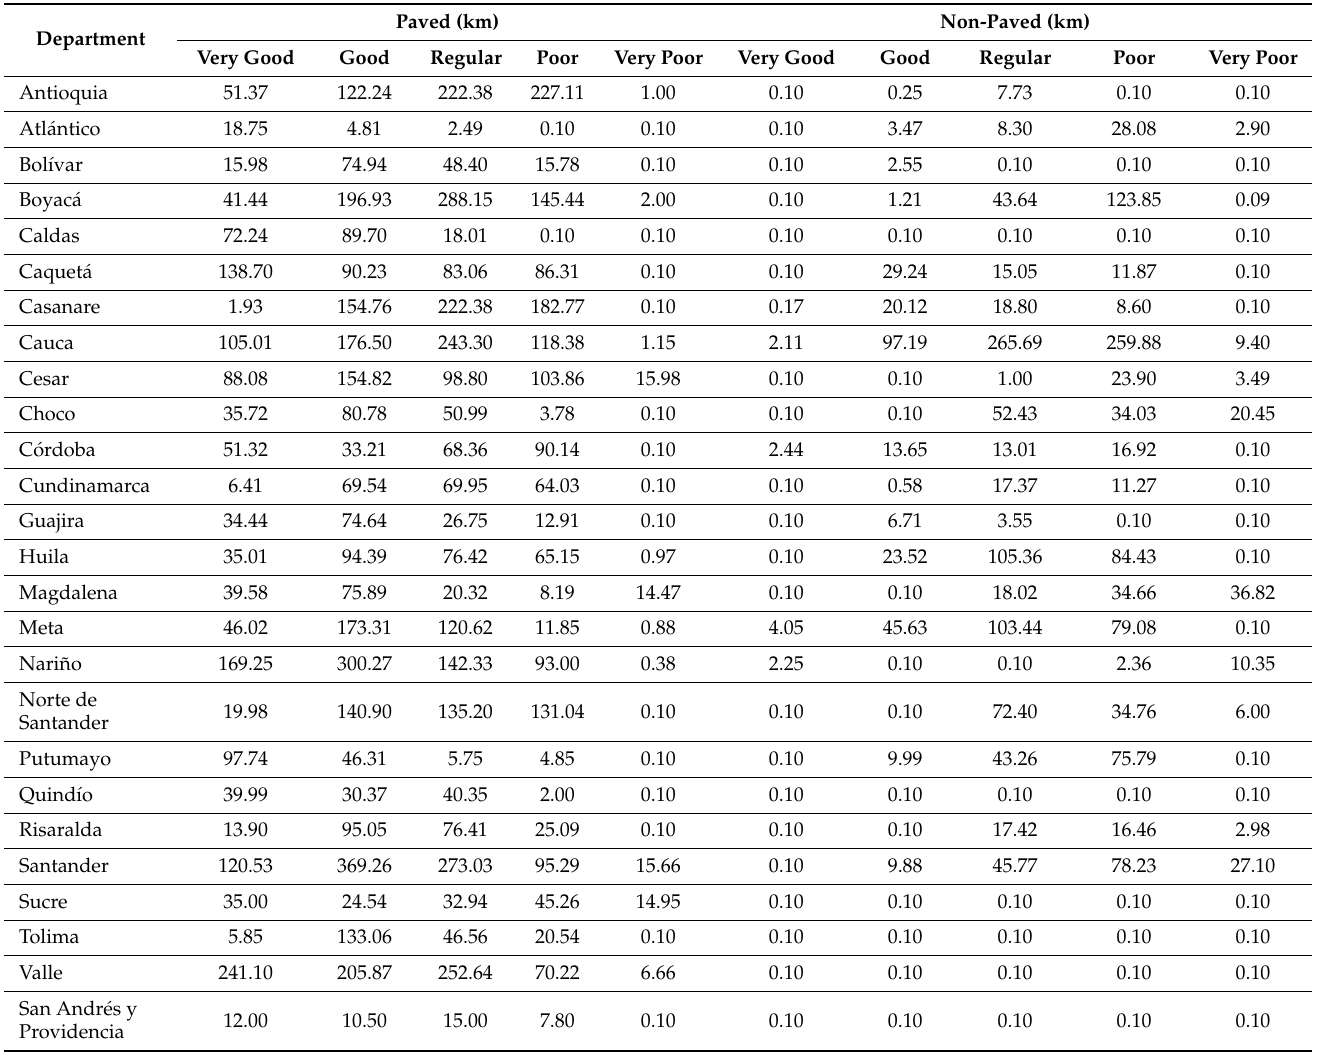
Table A7. Colombia’s departments’ road network lengths by condition in 2020.